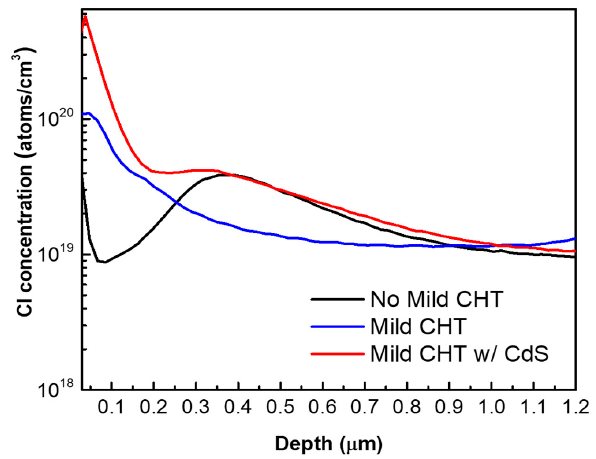
Figure 9. SIMS depth profile of Cl concentration for ZnTe:As BCL cells having received no mild CHT, mild CHT, and mild CHT with a CdS cap layer.